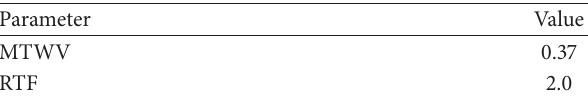
Table 1: Experimental